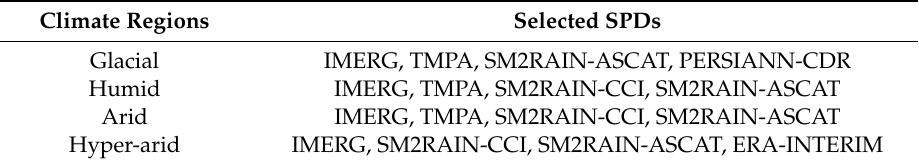
Table 4. Combination of selected SPDs for blending across all climate regions. Climate